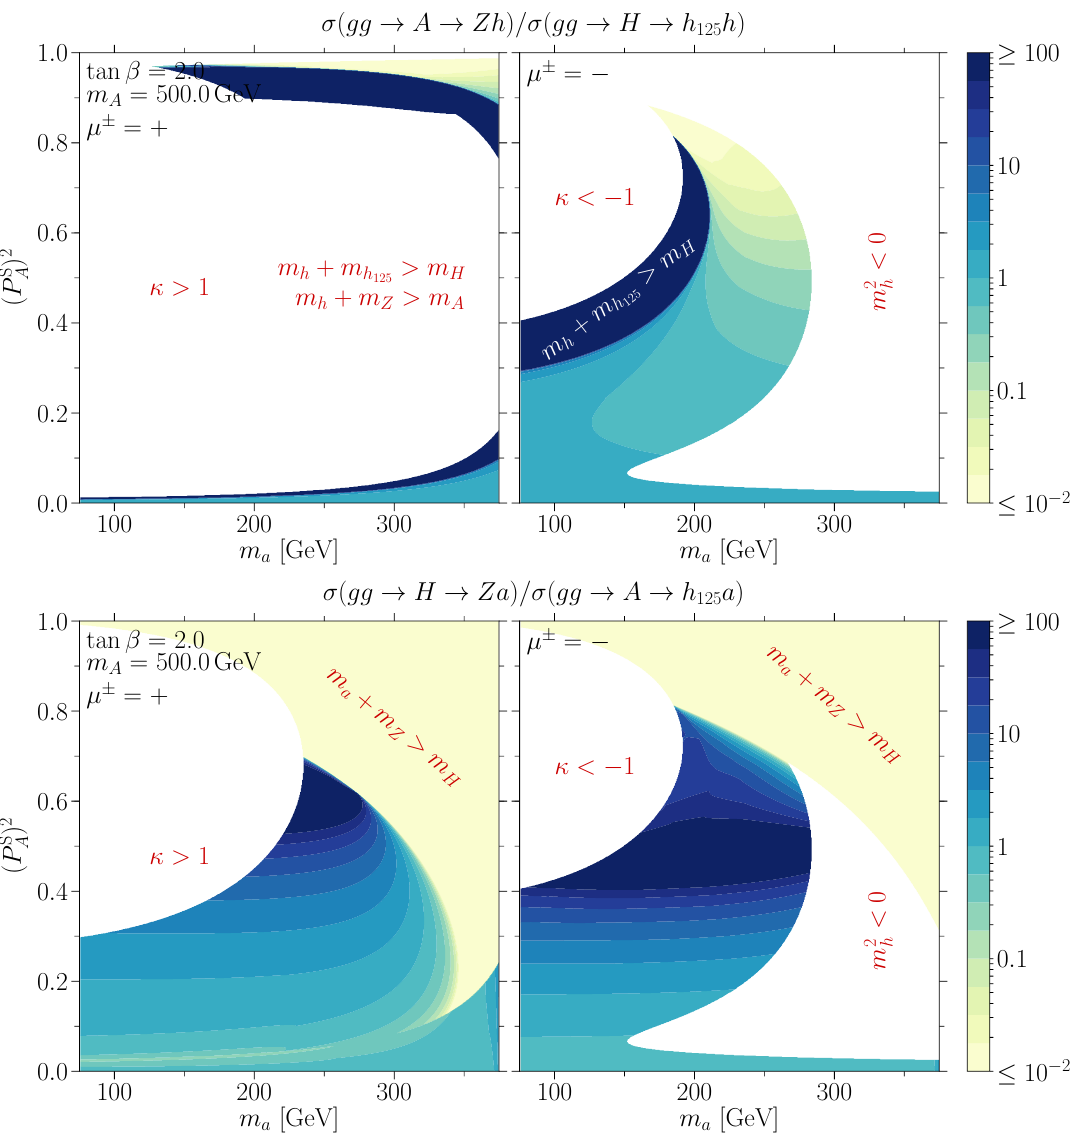
Figure 5 . Same as (cid:12)gure 4 but for the ratios given in eq. (3.3) [(3.4)] for the top [bottom] panel.